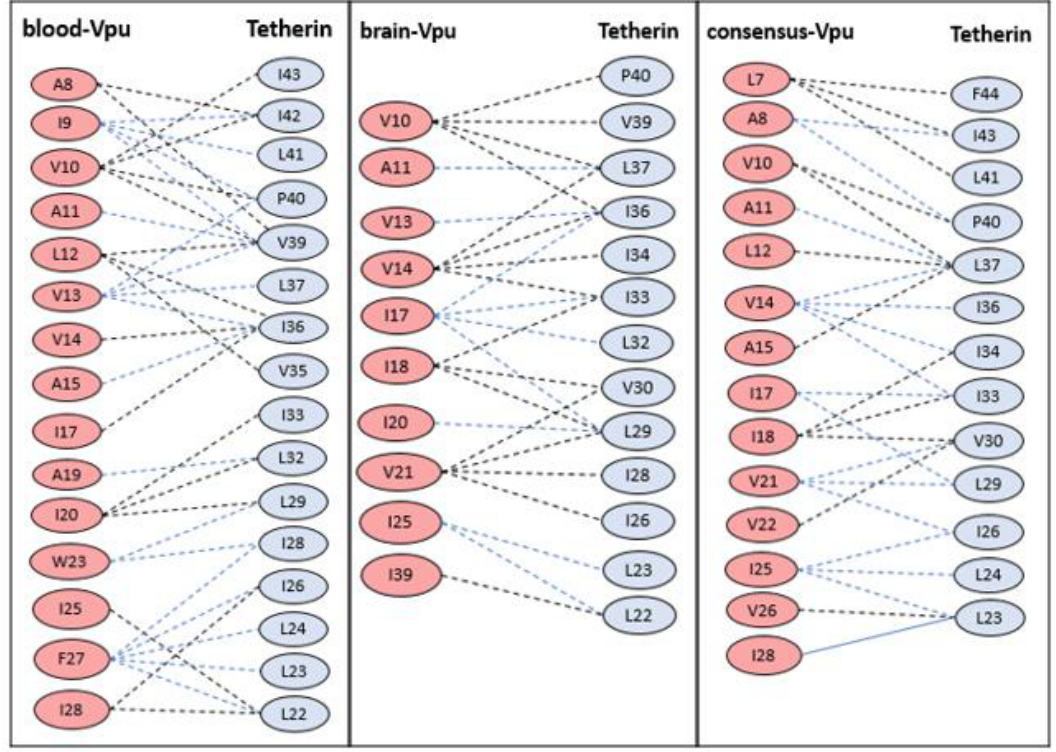
Figure 2. The hydrophobic interactions within 5 Å for wild-type blood-derived Vpu–tetherin complex, wild-type brain-derived Vpu–tetherin complex, and wild-type consensus Vpu–tetherin complex.